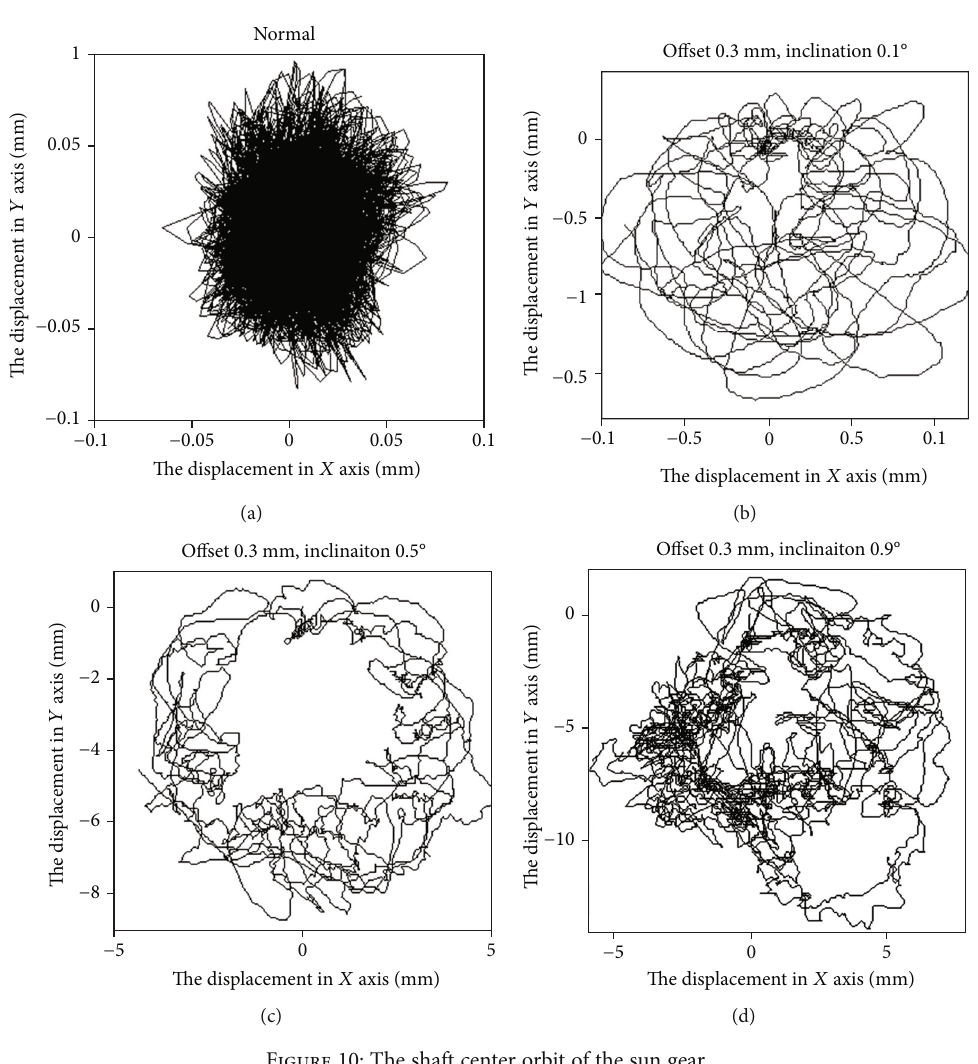
Figure 10: The shaft center orbit of the sun